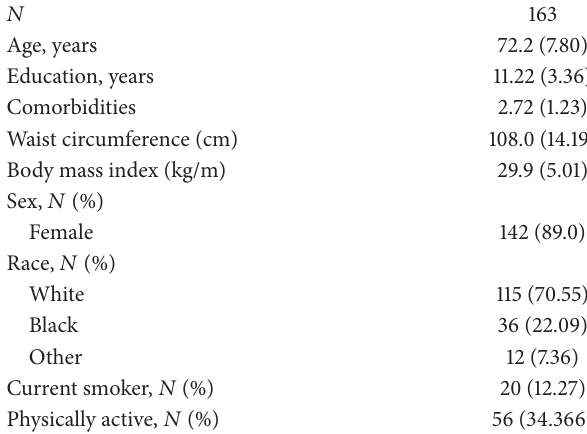
Table 4: Sample characteristics of missing